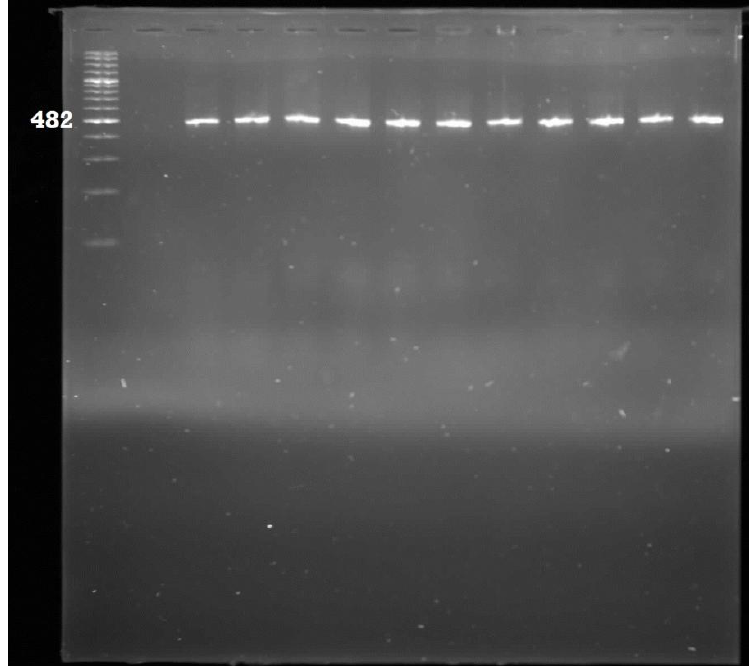
Figure 4. Gel electrophoresis for the detection of Enteropathogenic E. coli amplicons. Lane 1: 100 bp ladder; Lane 2: Negative control; Lane 3: Positive control; Lane 4–13: Positive